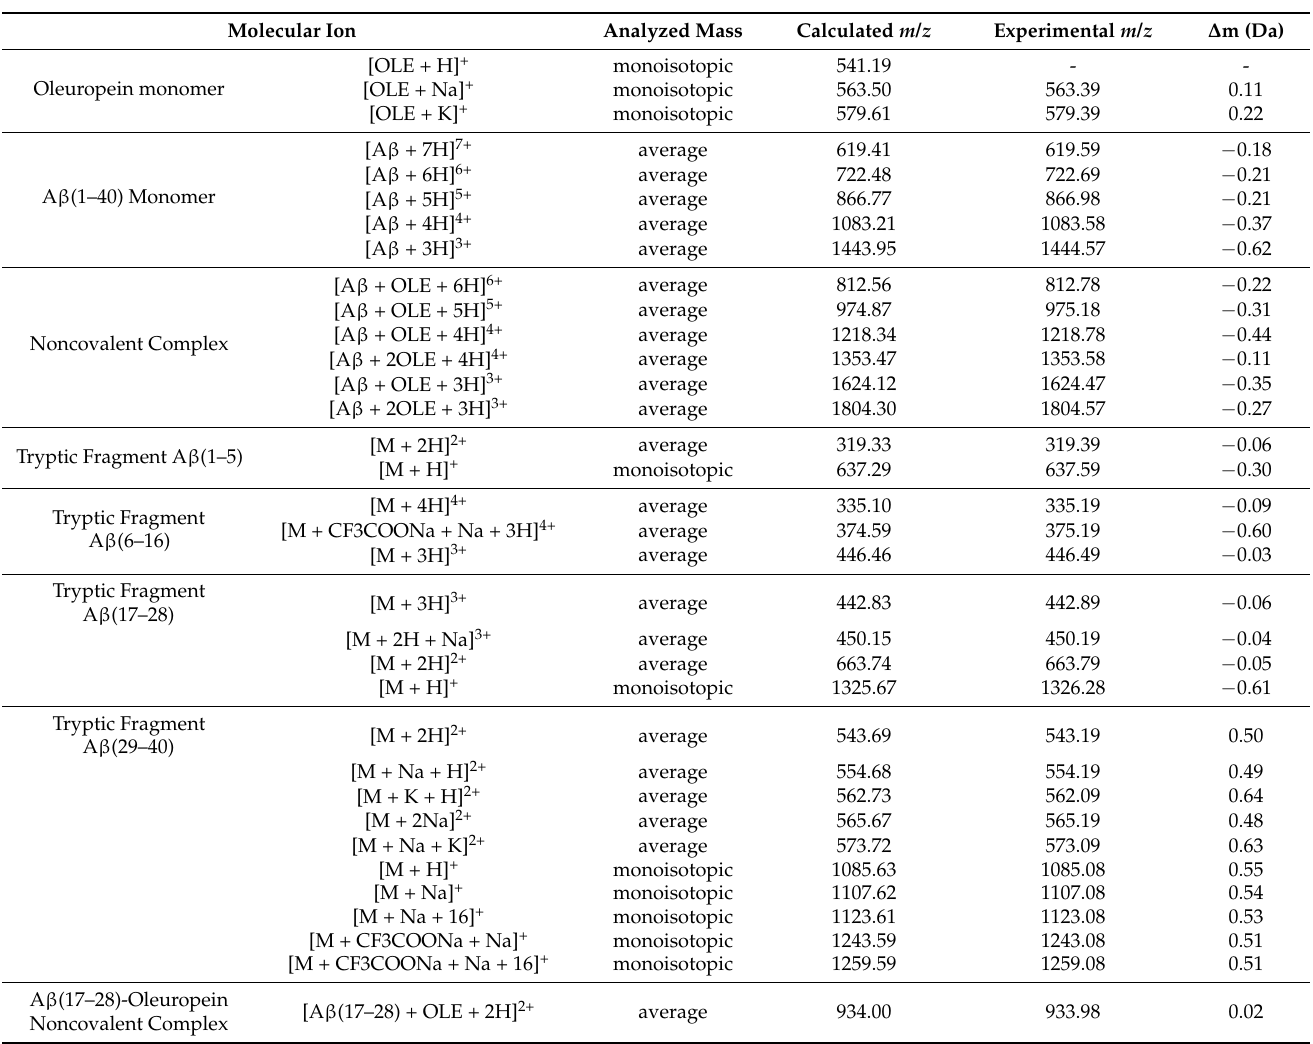
Table 1. Assignment of the signals observed in the mass